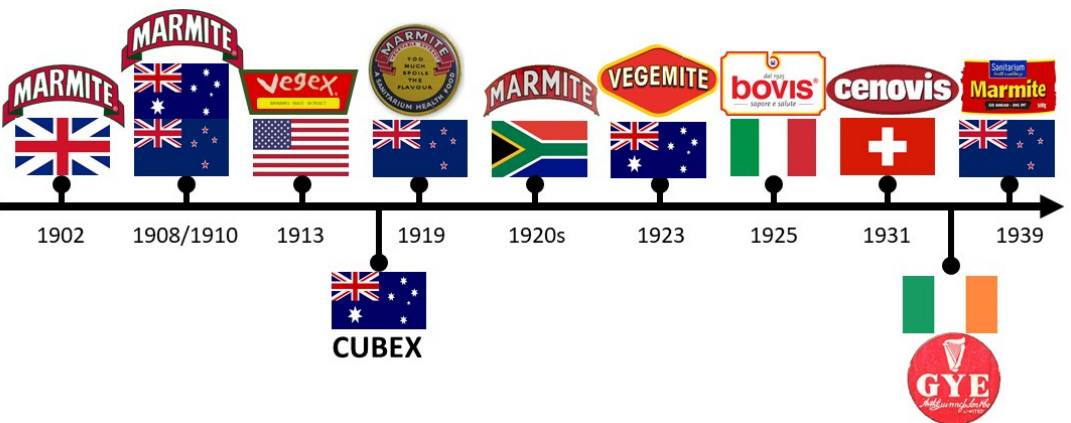
Figure 1. Timeline of the early development of yeast spreads indicating the brand, the year of commercial launch, and the country where the development/launch occurred, indicated by the respective country flag. All brands listed above the timeline are still currently still commercially available, those listed below the timeline are no longer commercially available. Timeline not to